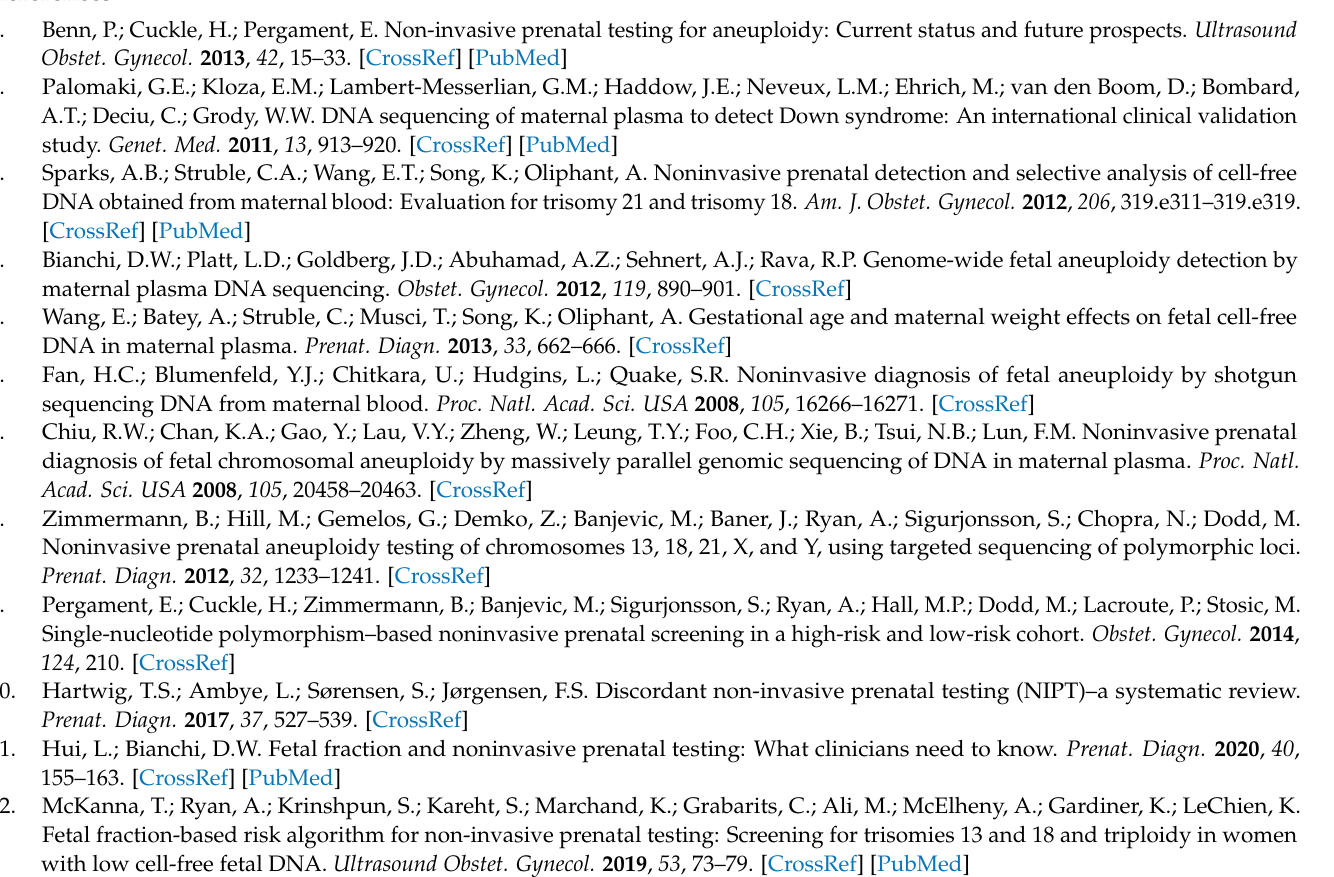
Characteristics Stratified by NIPT Method. Table S3: Validation Study Characteristics Stratified by Study Design. Table S4: Excel document with data extracted from manuscripts of all Validation studies. (‘All Validation’ tab). Table S5: Mean Diagnostic Odds Ratios Stratified by Study Design. Table S6: Summary of Clinical Experience Study Characteristics by NIPT Methodology. Table S7: Excel document with data extracted from manuscripts of all Clinical Experience studies. (‘All Clinical Experience’ tab). Table S8: Number and Percentage of High-Risk Results Where There was Follow-up. Figure S1: Forest Plots of all Data. References [25–166] are cited in the supplementary